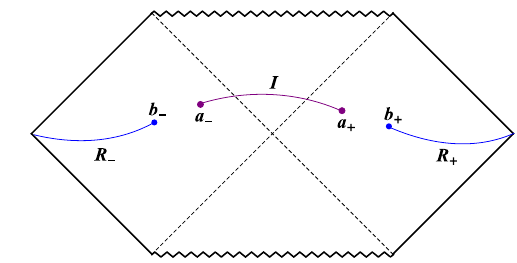
Fig. 4 The Penrose diagram of the eternal neutral black hole in mas- sive gravity in the absence (left panel) and the presence (right panel) of the island. The region of Hawking radiation consists of two parts R − and R + which lie on the left and right wedges, respectively. b − and b +